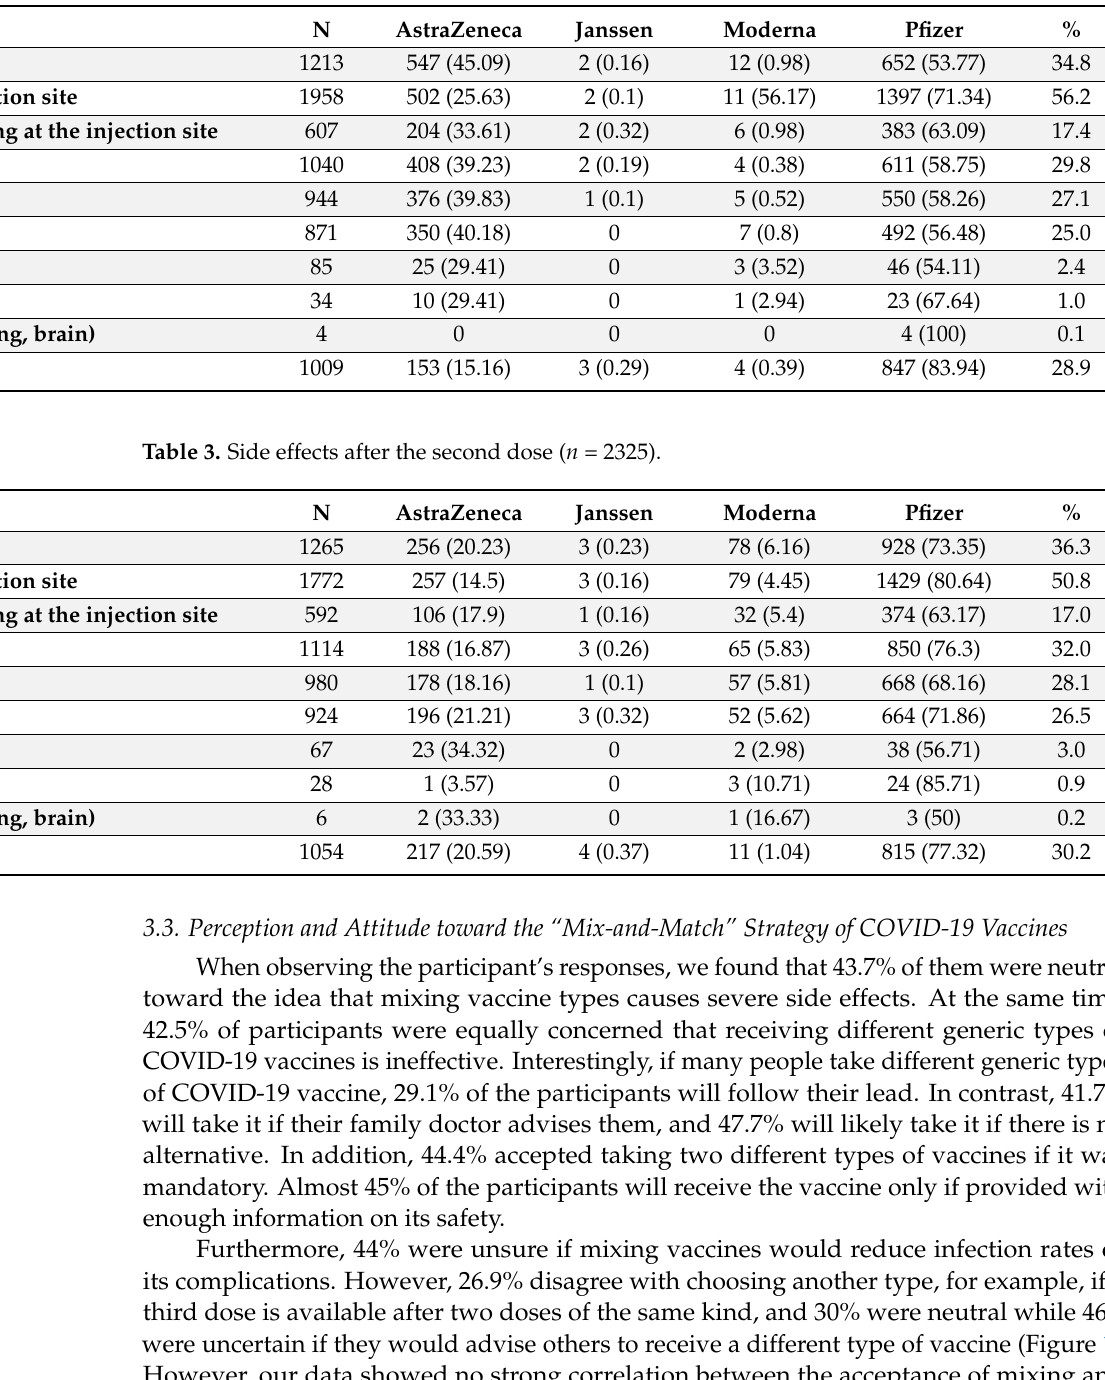
Table 2. Side effects after the first dose ( n = 2354).